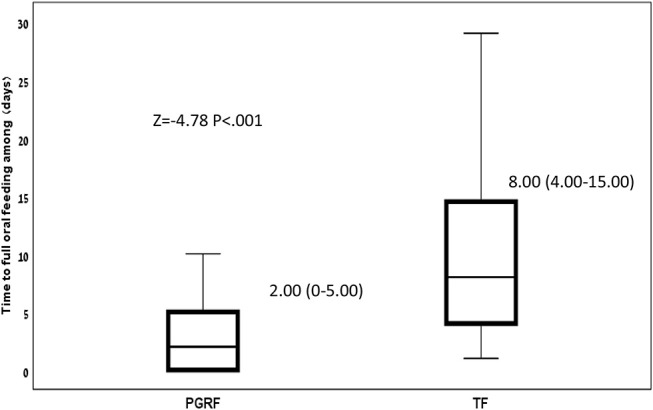
Time to full oral feeding among the study groups. Data are presented as median (P25-P75). Statistical analysis was based on Mann-Whitney-test. PGRF, parental guided responsive feeding; TF, traditional feeding.